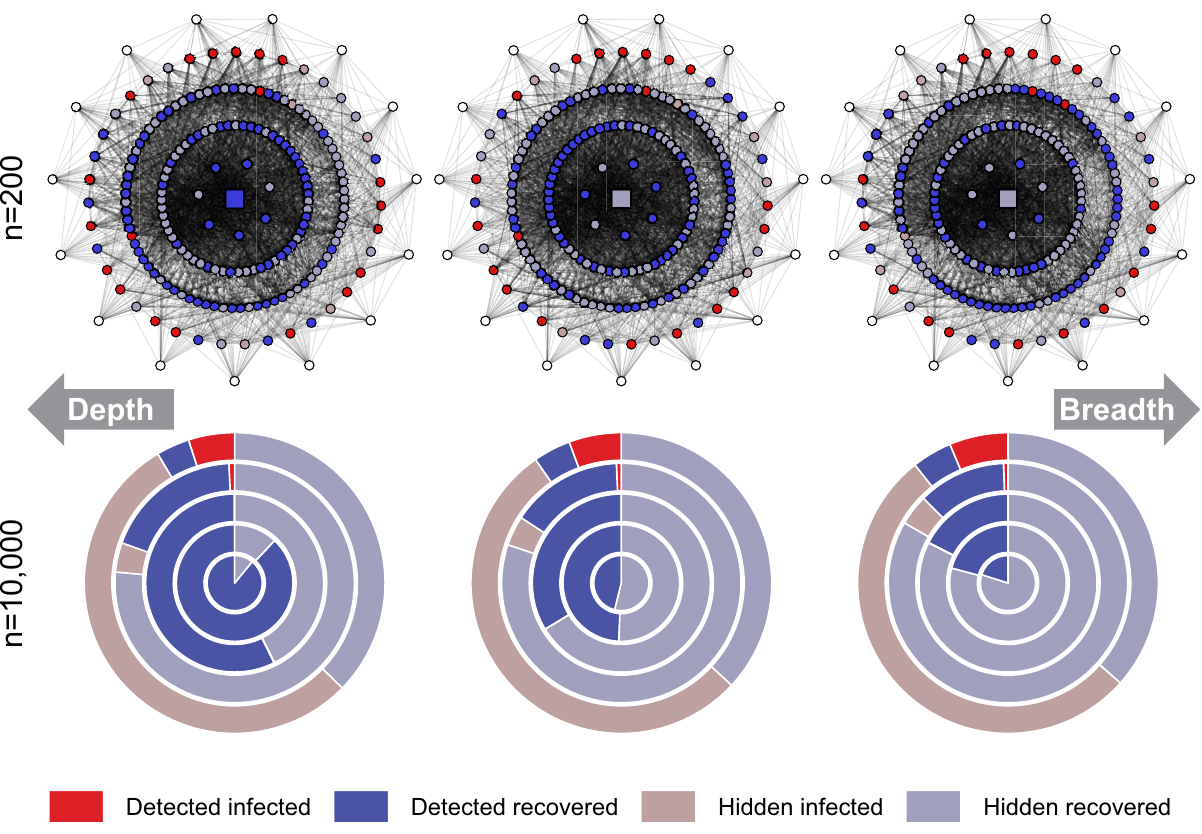
Figure 2. Tracing process for different values of the breadth parameter β tr in Watts–Strogatz networks. The first row presents an example of a single simulation of a tracing process in a network with 200 nodes and a budget of b = 10 . The columns correspond to β tr = 1 , β tr = 5 , and β tr = 10 . The source is represented as the square node in the center. The four inner rings of nodes contain nodes that got infected in the first, second, third, and fourth week, with rings further from the middle corresponding to infections later. Red nodes are infected after 28 days. Blue nodes are recovered. A vivid color indicates that the node got detected by the tracing process for the given value of β tr , and a muted color indicates that the node never got detected (see the legend of the figure). The outer ring contains nodes that never got infected (marked white). The second row presents results for networks with 10,000 nodes and tracing budget b = 100 , aggregated over 1000 simulation runs. The middle circle represents the diffusion source, while the colored rings represent nodes in the first, second, third, and fourth week, with rings further from the middle corresponding to infections later. The columns correspond to β tr = 1 , β tr = 30 , and β tr = 100